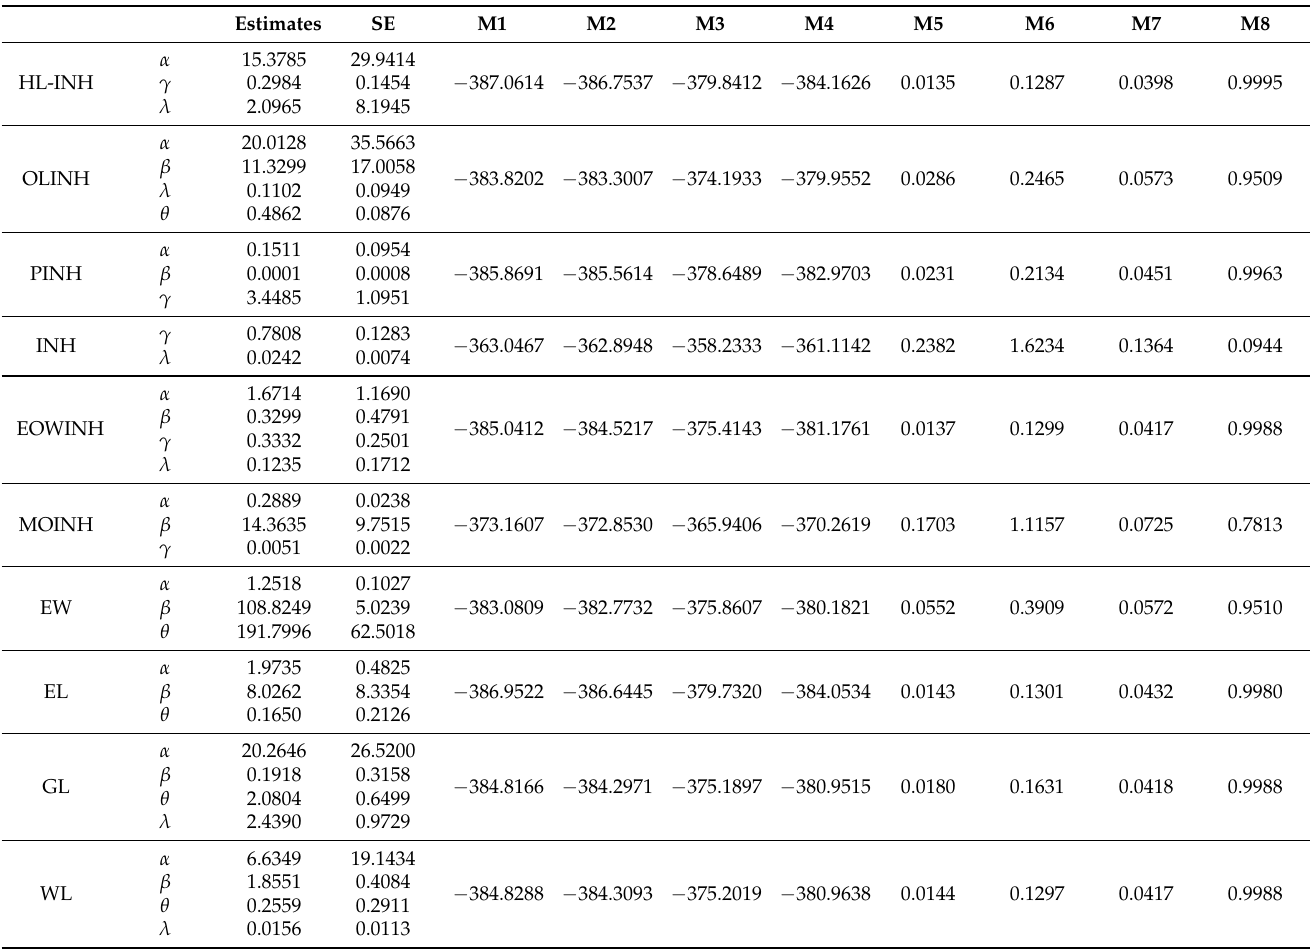
Table 10. MLE for each model with different measures: COVID-19